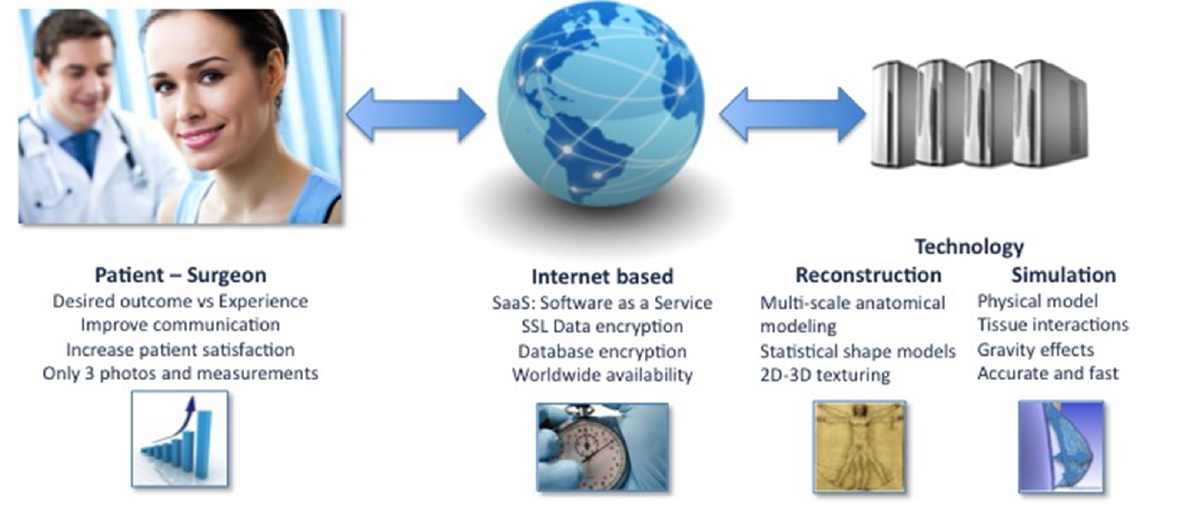
Figure 1. General overview of the developed system. An Internet-based solution combining advanced technologies enables a realistic, patient-specific, simulated clinical scenario. 2D = 2-dimensional; 3D = 3-dimensional.